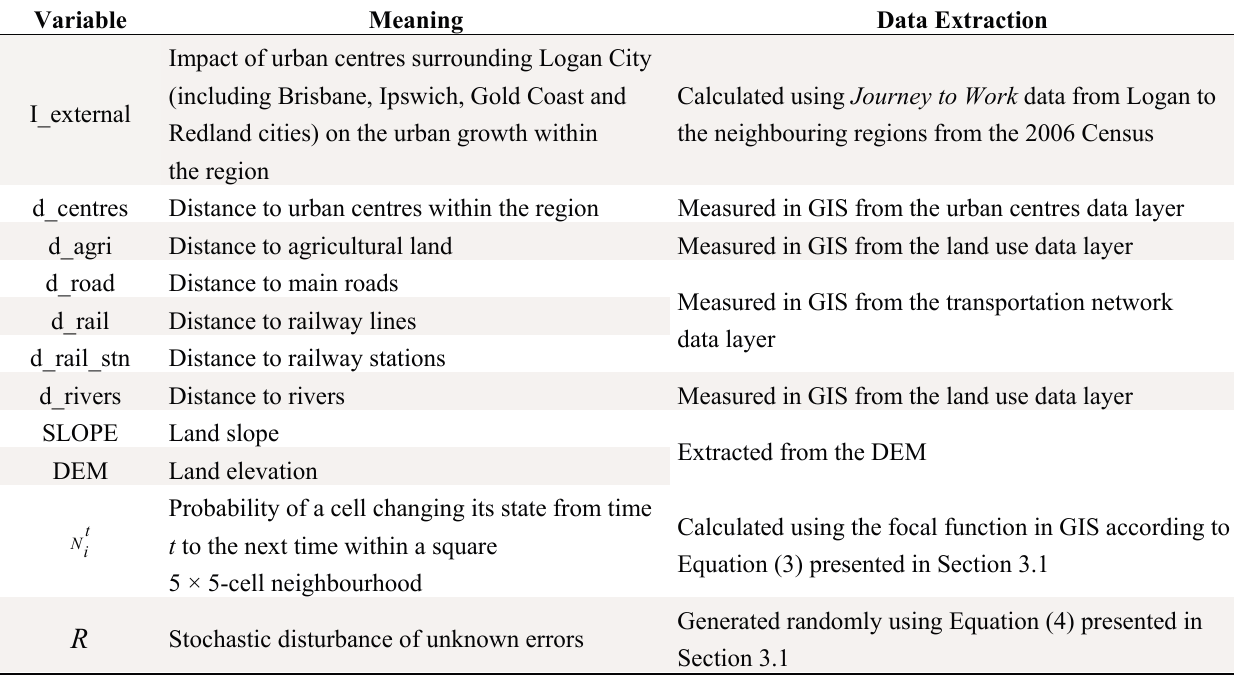
Table 1. Variables used to compute land conversion probabilities.